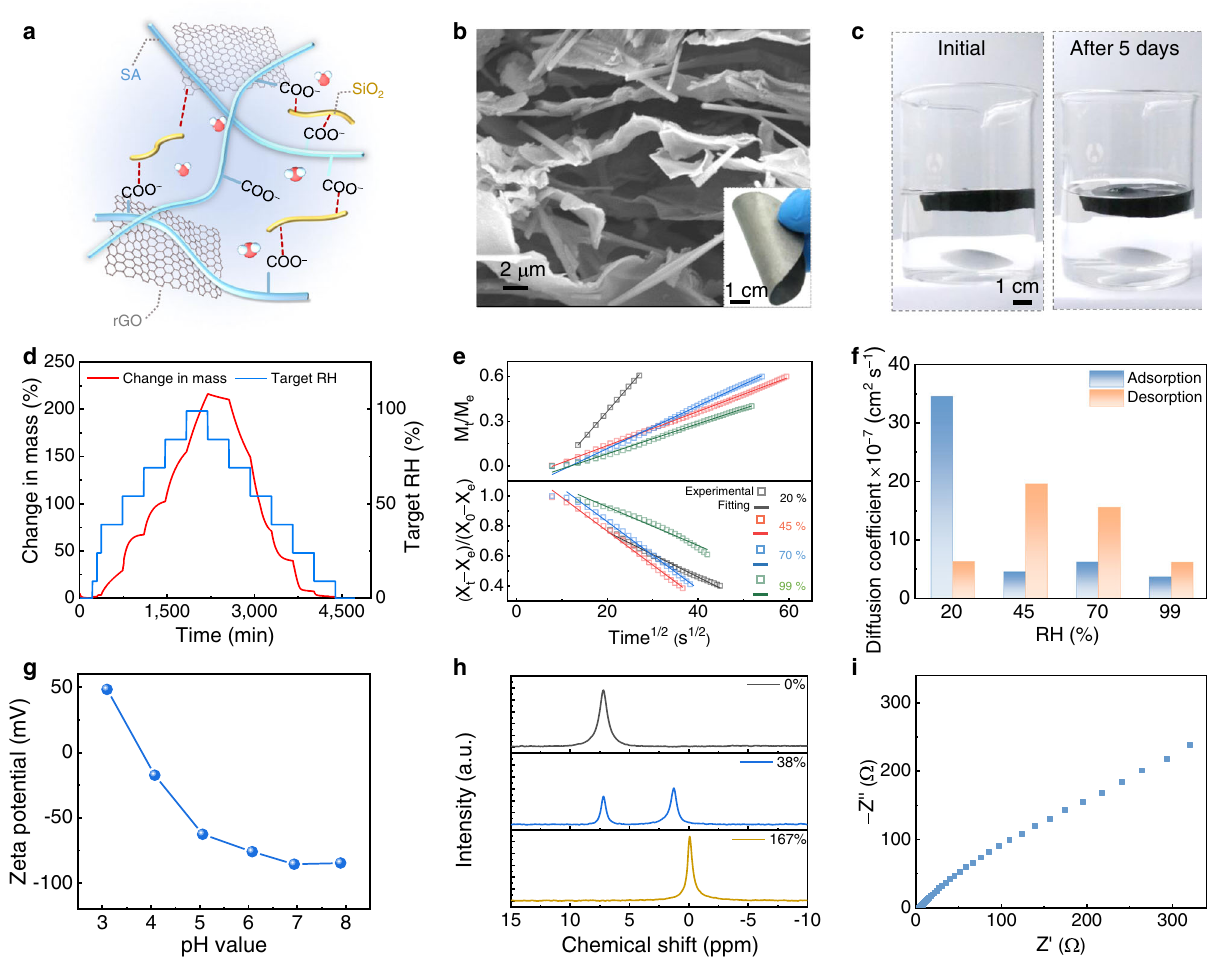
Fig. 2 Structure and properties of SAG fi lm. a Schematic of the SAG fi lm composed of SA chains, SiO 2 nano fi ber, and rGO nanosheet. b Scanning electron microscopic (SEM) image of SAG fi lm. Inset is the photograph of fl exible SAG fi lm. c Photos of SAG fi lm in water during stirring (200 rpm) before and after 5 days. d Moisture adsorption and desorption kinetics for SAG fi lm at 40 o C. e M t /M e and ( X t − X e )/( X 0 − X e ) as a function of square root of time. f Adsorption and desorption diffusion coef fi cient of SAG fi lm under different RH at 40 o C. g Zeta potential of SAG fi lm within the pH range from 3 to 8. h 23 Na solid state NMR spectra of SAG fi lm with various water content. i The electrochemical impedance spectra of SAG fi lm at 100%